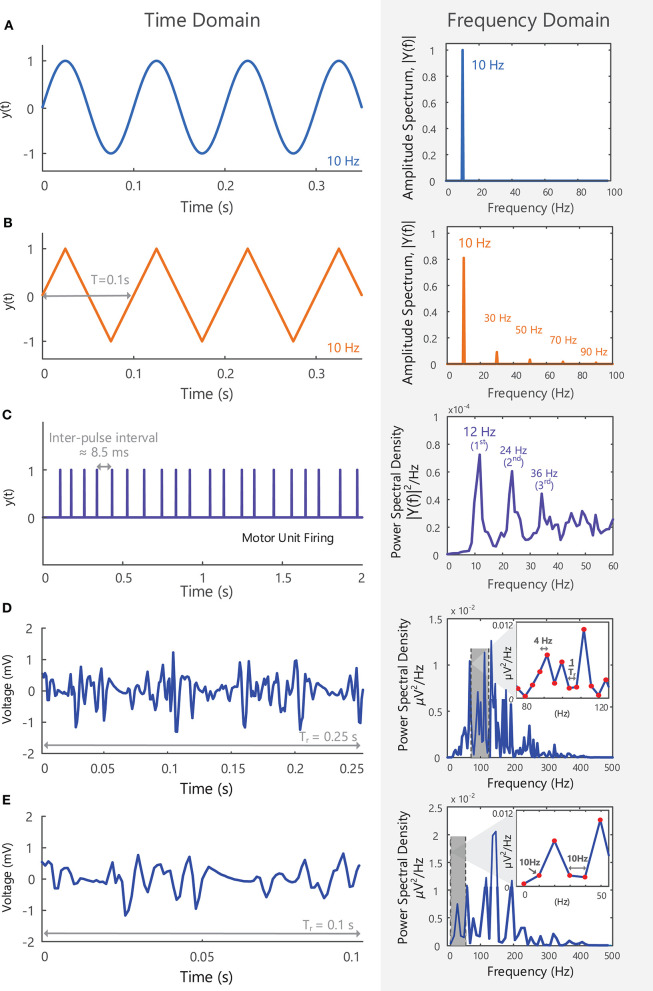
(A) A 10 Hz sine wave with an amplitude of 1, shown in the time domain, y(t), and in the frequency domain, Y(f), after applying a Fourier Transform. All the power within the signal is contained at a single frequency (i.e., fundamental frequency or first harmonic−10 Hz). (B) A triangle wave with a repetition rate of 10 Hz shown in the time and frequency domain, y(t) and Y(f), respectively. As a non-sinusoidal wave, it contains frequency components at multiples of the first harmonic (note: triangle waves contain only odd harmonics). See Example (iii) in Tutorial Code. (C) The firing of a single motor unit over 2 s, shown in the time and frequency domain. The motor unit fires at an average frequency of 12 Hz (fundamental frequency of the spike train), but spectral peaks at multiples of 12 Hz can be observed in the frequency domain. (D) A 0.25 s EMG signal in the time and frequency domain. The length of the signal determines the frequency resolution (1/Tr = 4 Hz) and the lowest frequency that can be detected in the frequency domain (4 Hz). (E) A 0.1 s EMG signal is too short to observe frequencies lower than 10 Hz and can only detect frequency components that are multiples of 10 Hz.